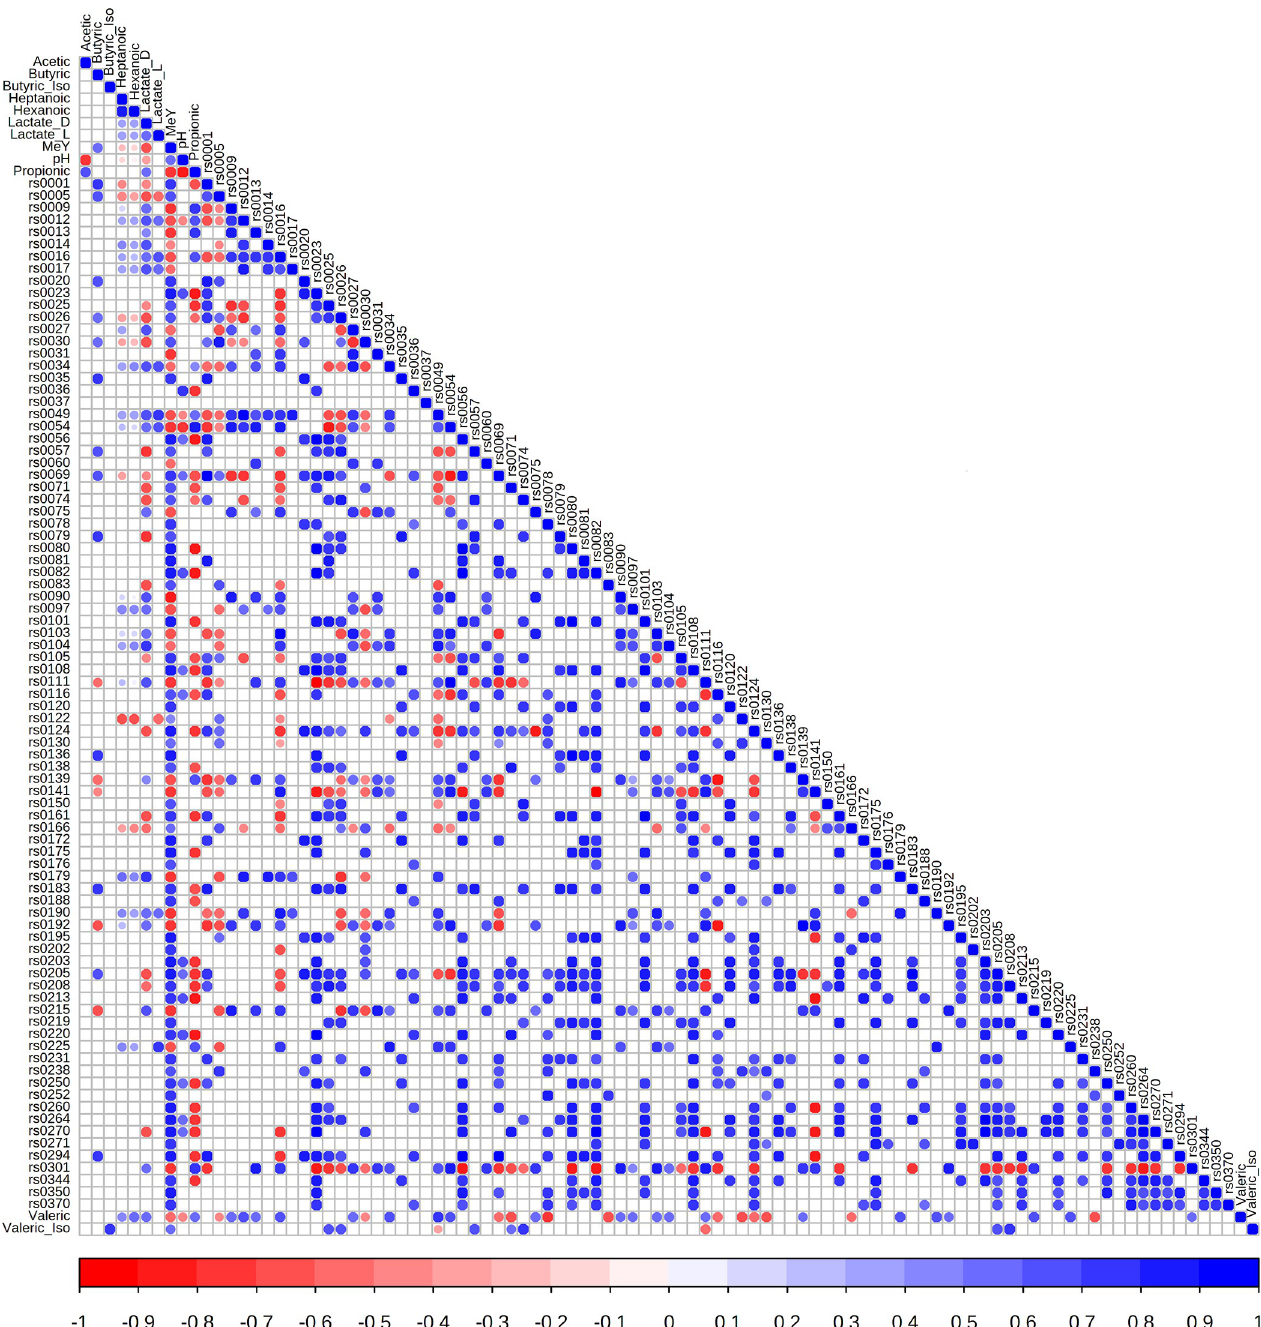
Fig 5. Correlation of OTU vs MeY, pH and ruminal acids. Correlogram illustrating the Spearman Rank Correlation analysis of the abundance of 83 OTU versus each other and MeY (CH4 yield), ruminal pH, D-lactate, L-lactate, acetic acid, propionic acid, iso-butyric acid, butyric acid, iso-valeric acid, valeric acid, hexanoic acid and heptanoic acid. The 83 OTU are those with an abundance of at least 1000cpm in at least 5 cows, a significant correlation with MeY ( P < 0.01) and a logFC (log2 fold change) magnitude of at least 2.5 when comparing a wheat to a non-wheat diet. Also included are the 2 most abundant methanogenic archaea. Correlation coefficients are rendered as coloured circles (Red negative or Blue positive) if P < 0.001. Colour intensity reflects degree of correlation.